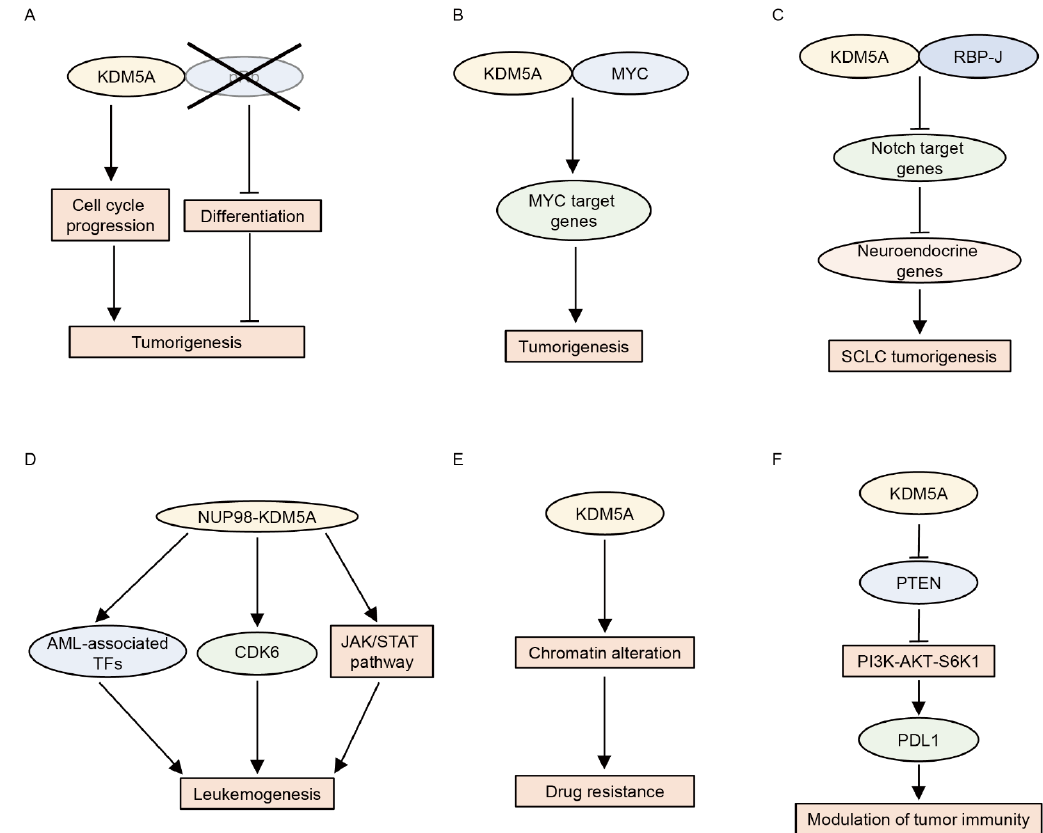
Figure 3. Multiple functions of KDM5A in cancer. ( A ) In pRb-deficient cells, KDM5A promotes tu- morigenesis by cell cycle progression and differentiation block. ( B ) KDM5A and MYC coordinately promote tumorigenesis by activating MYC target gene expression. ( C ) KDM5A and RBP-J promote small cell lung cancer (SCLC) by inducing the expression of neuroendocrine genes through the re- pression of Notch target genes. ( D ) NUP98 – KDM5A induces leukemogenesis by activating the ex- pression of acute myeloid leukemia (AML)-associated transcription factors (TFs) and CDK6, as well as the JAK-STAT pathway. ( E ) KDM5A confers drug resistance by chromatin alterations. ( F ) KDM5A elevates PDL1 expression by activating the PI3K – AKT – S6K1 cascade through the down- regulation of PTEN. 4.2. KDM5B KDM5B was first identified as an upregulated gene in breast cancer [92]. Later, Ya- mane et al. showed that KDM5B is an H3K4 demethylase that promotes the proliferation of breast cancer cells by repressing tumor suppressor genes, including HOXA5 and BRCA1 , through H3K4me3 demethylation [8]. Subsequent studies further delineated the functions of KDM5B in breast cancer. KDM5B is frequently amplified and overexpressed in ER + luminal breast cancer cells, and KDM5B governs the luminal lineage transcriptional program [93]. Higher KDM5B activity is associated with poor prognosis in patients with ER + breast cancer [93]. EMSY is also amplified in ER + luminal breast cancer and acts as an oncogene by downregulating miR-31, an antimetastatic microRNA [38]. KDM5B physi- cally interacts with EMSY and suppresses miR-31 via H3K4me3 demethylation [38]. KDM5B also interacts with ER and enhances E2-dependent tumor growth in ER + breast cancer cells [49]. Mitra et al. showed that KDM5B regulates cyclinD1 expression and cell